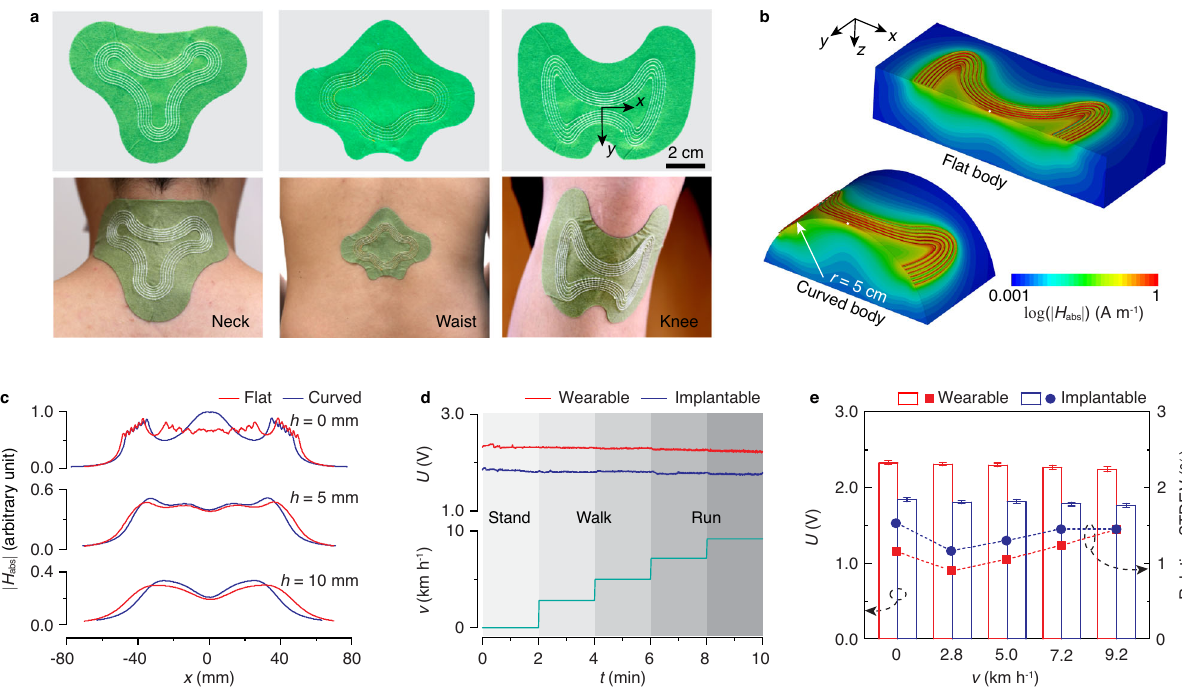
Fig. 4 Conformal textile skin patches. a Images of skin patches fabricated using digital embroidery of liquid metal fi bers attached to the neck, waist, and knee. The skin patches are used as wearable transmitters connected with a signal generator for wireless powering of the underneath wearable and implantable devices during daily activities. b Simulated magnetic fi eld ∣ H abs ∣ on a fl at and curved (5-cm radius) body phantom. The cutting plane is set to the center of the skin patch (white dot). c Field pro fi les along the cutting plane at varying depth h . d Received voltage U of wearable and implantable device, wirelessly powered by the skin patch, during physical activities with speed v increasing from 0, 2.8, 5, 7.2, to 9.2 km h − 1 , indicated by the shadows. The input power of the skin patch is 20 dBm. e Comparison of U and its relative standard deviation (STDEV) during different activities. Error bars show mean ± s.d. Source data are provided as a Source Data fi